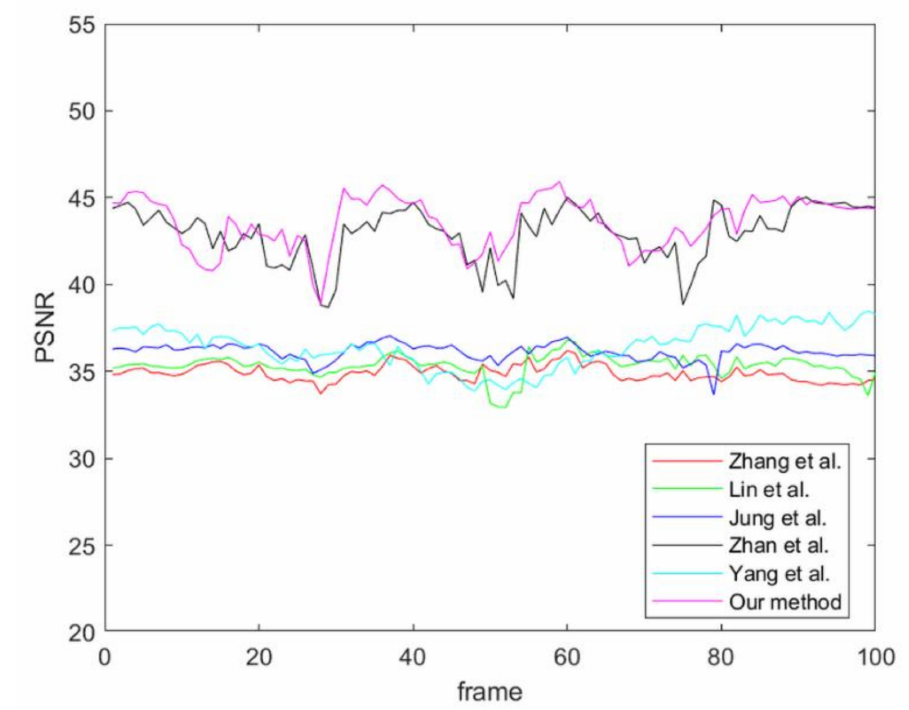
Figure 7. PSNR values for tanks video clip in comparison of our proposed method, and methods of Zhang et al., Lin et al., Jung et al., Zhan et al., and Yang et al.